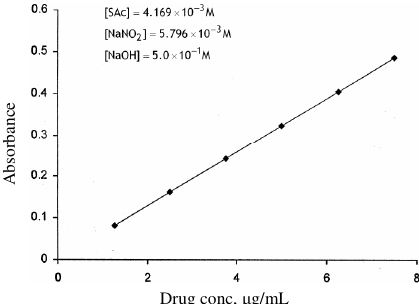
Figure 7. Beer’s law plot of REB –